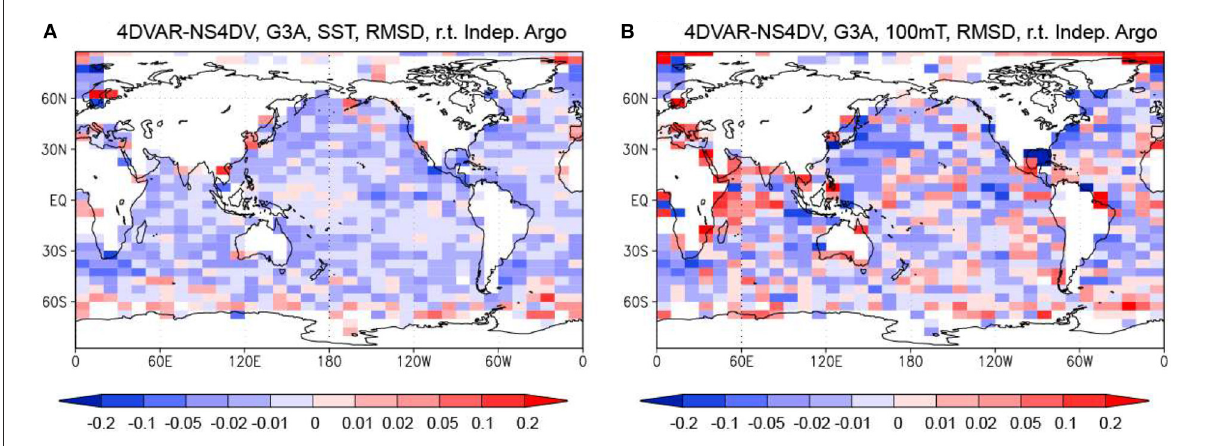
FIGURE11 Difference of RMSDs of the MOVE-G3A temperature relative to the independent Argo float data between the 4DVAR and NS4DV Runs. (A) Difference of the RMSD at the surface. (B) Difference of the RMSDs at 100m depth. Blue colors mean that the RMSD are smaller for the 4DVAR Run. Units in ◦